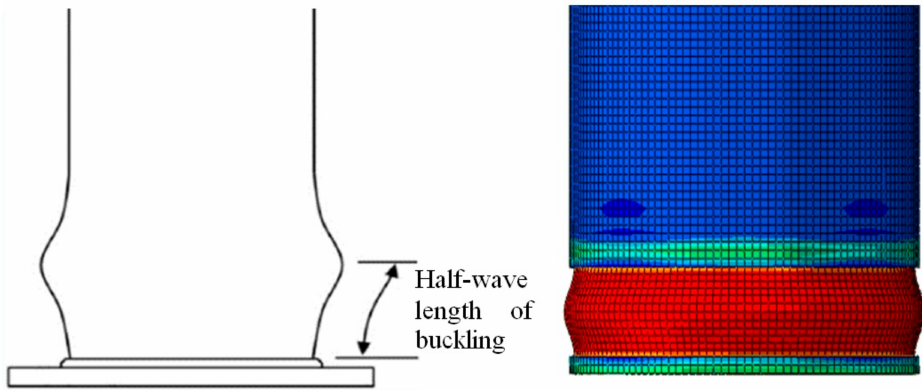
Figure 6. Length of half-wave buckling of a short tubular steel column.